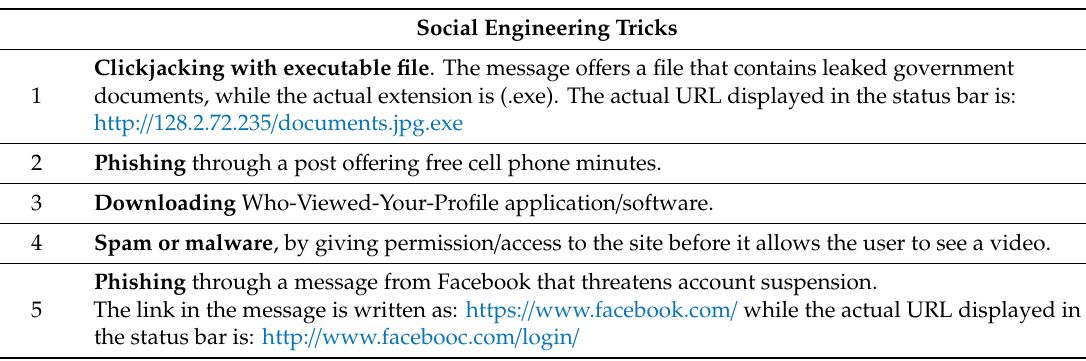
Table 1. Social engineering requests /